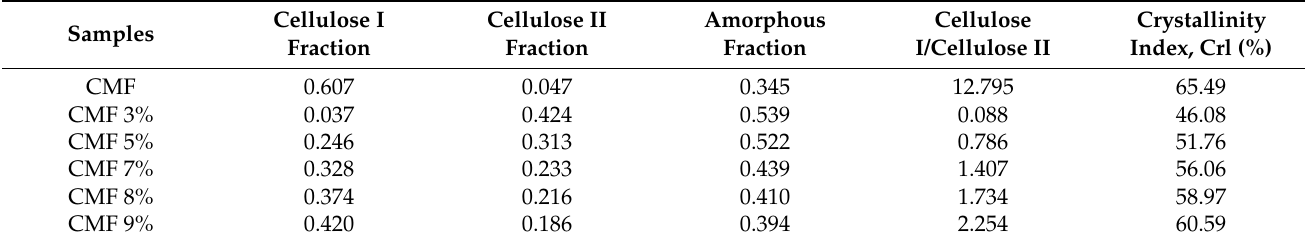
Table 1. Cellulose I and cellulose II fractions at CMF different